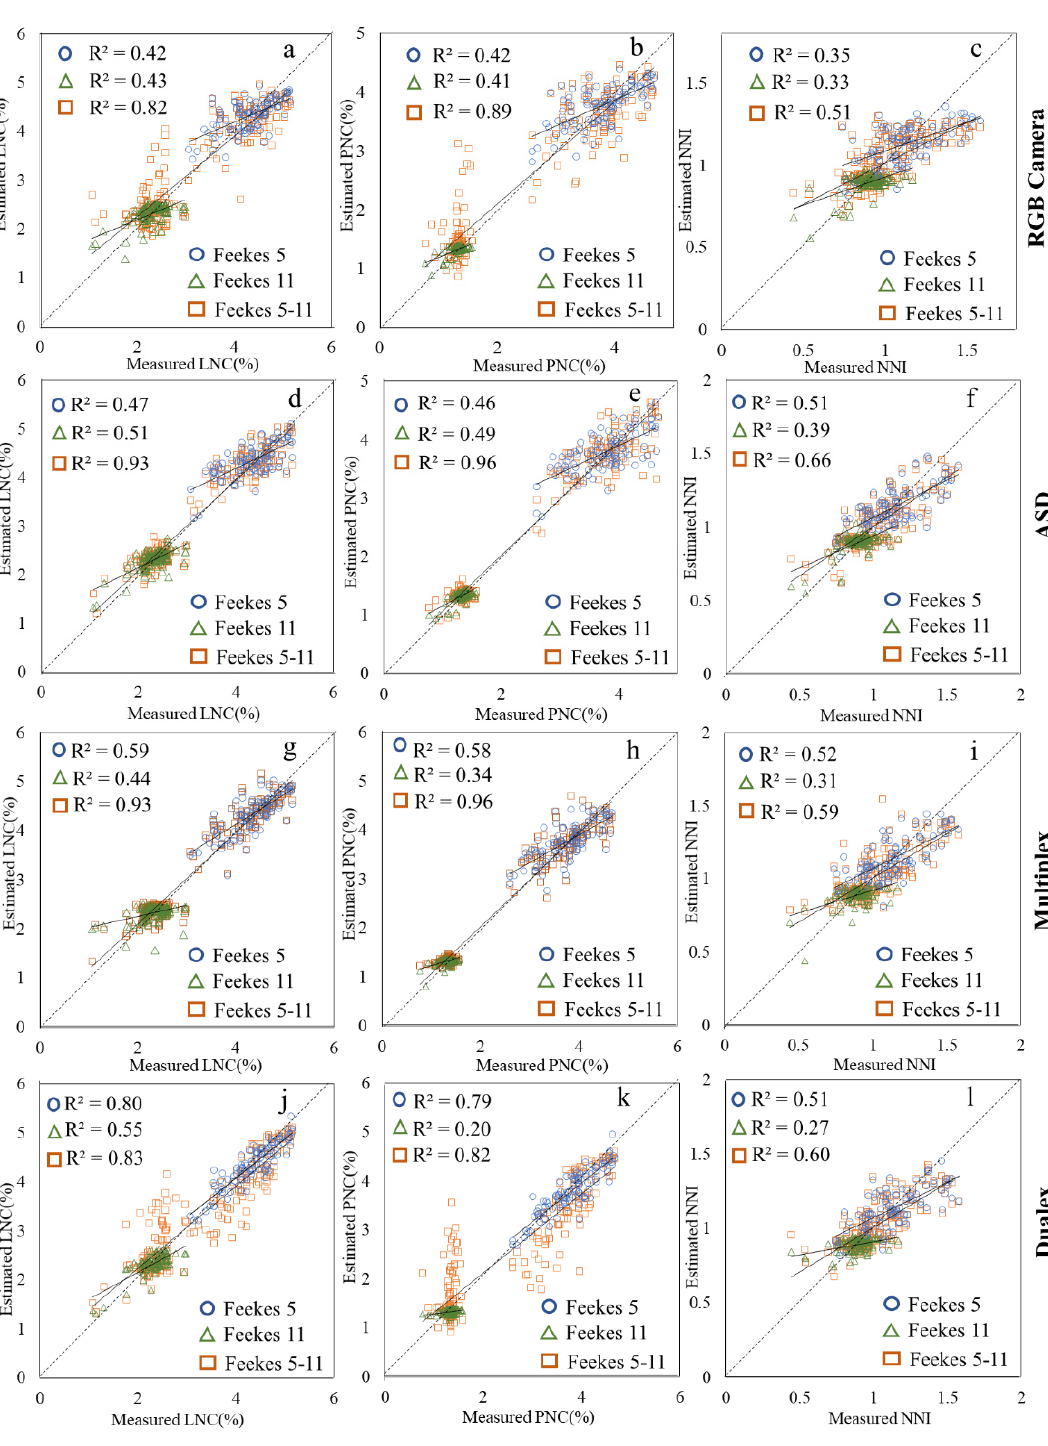
Figure 5. Measured vs. estimated LNC (left), PNC (middle), and NNI (right) values along the 1:1 line through the GPR-SBBR method based on best VIs for four different sensors. ( a ) LNC based on RGB sensor; ( b ) PNC based on RGB sensor; ( c ) NNI based on RGB sensor; ( d ) LNC based on ASD sensor; ( e ) PNC based on ASD sensor; ( f ) NNI based on ASD sensor; ( g ) LNC based on Multiplex sensor; ( h ) PNC based on Multiplex sensor; ( i ) NNI based on Multiplex sensor; ( j ) LNC based on Dualex sensor; ( k ) PNC based on Dualex sensor; and ( l ) NNI based on Dualex sensor.